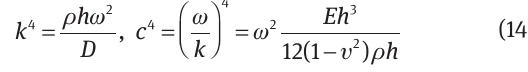
variations for Luneburg, Maxwell fish-eye, 90 ° rotating, Eaton, b